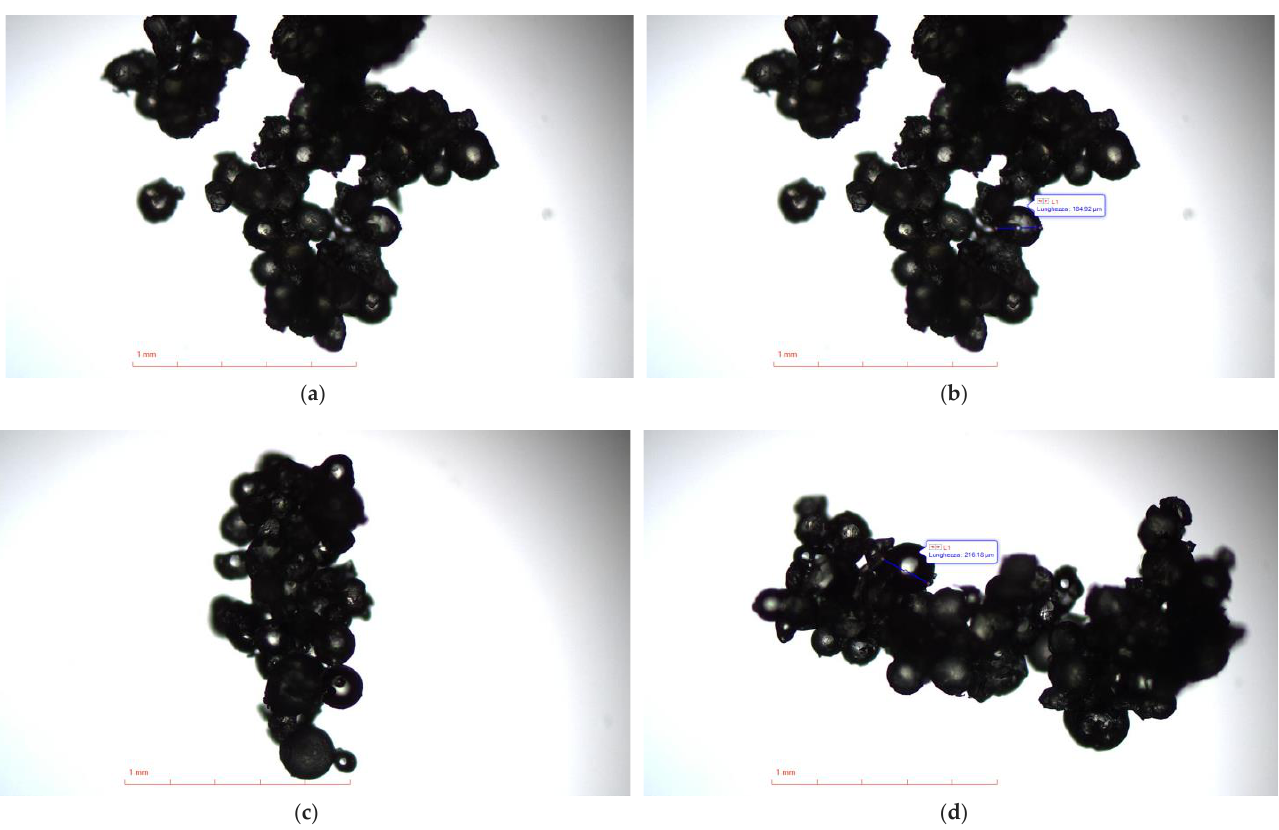
Figure 11. Optical microphotographs (using a 4 × objective) of the dried D-R1HG-3c ( a , b ) and D-R1HG-4b ( c , d ).